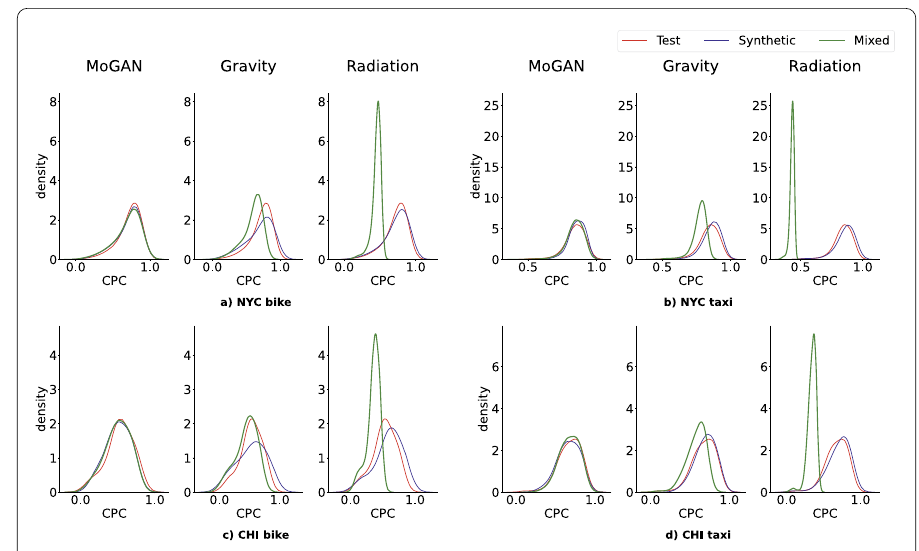
Figure 4 Results for the CPC. Distributions of the pairwise CPC distances between mobility networks in the test set (red), synthetic set (blue), and mixed set (green), for the four datasets. For each dataset, we compare the overlap of the distributions of MoGAN and the two baselines (Gravity and Radiation). For both the Gravity model and the Radiation model, the three distributions are significantly different, especially for the latter